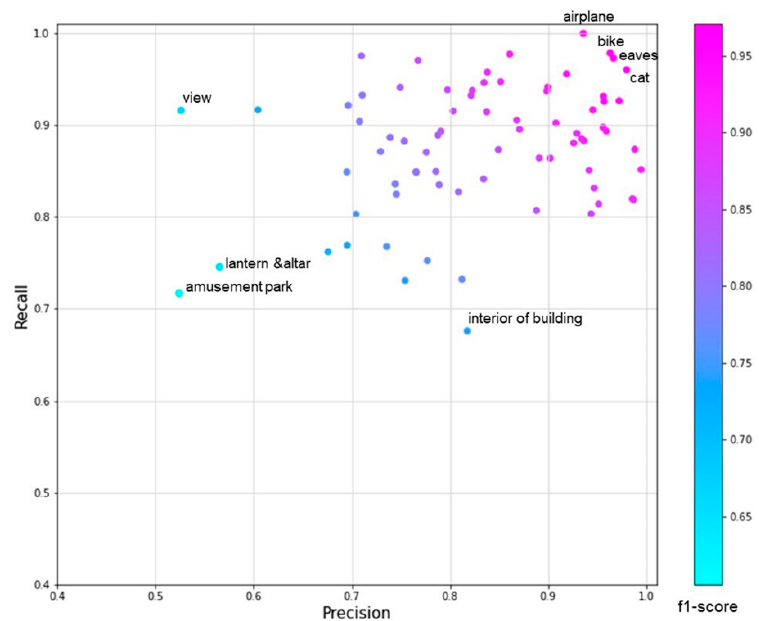
Figure 8. Precision, recall, and F1-score by scene.